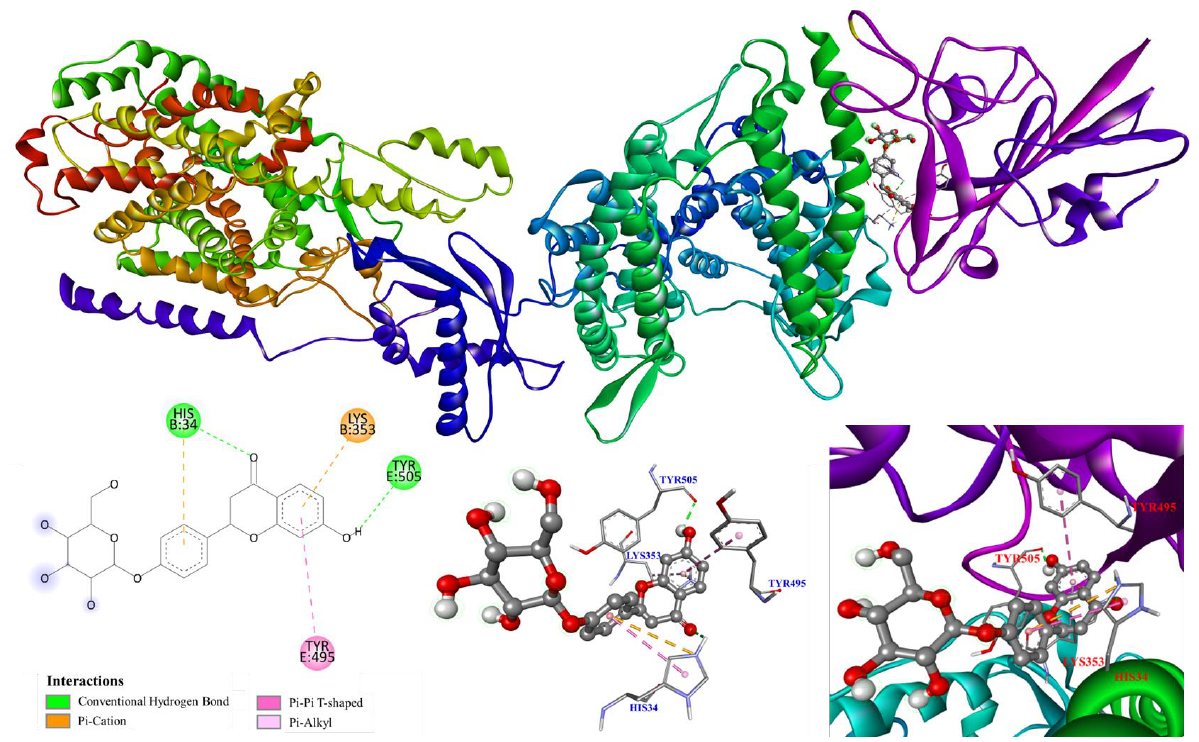
Figure 4. Interactions of liquiritin between SARS-CoV-2-RBD and ACE2 in silico.